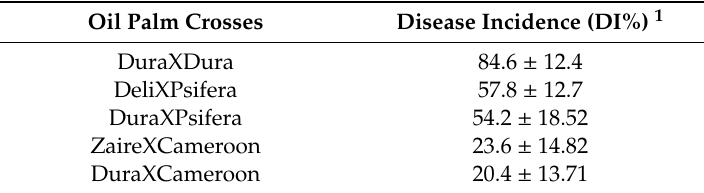
Table 1. Disease incidence (DI%) of three-month-old oil palm genotypes/crosses challenged with Ganoderma boninense .